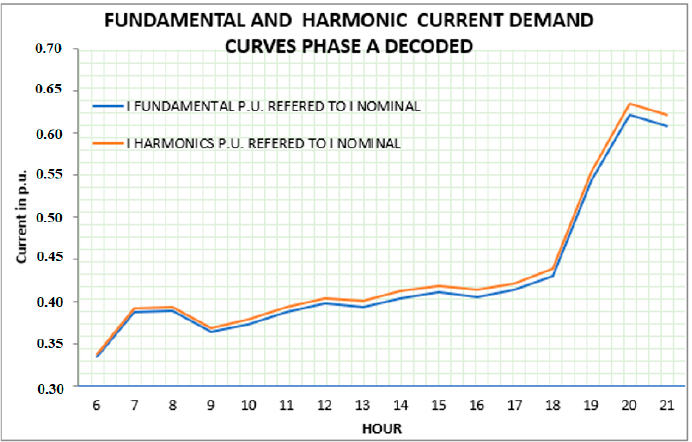
Figure 6. Standardized currents.